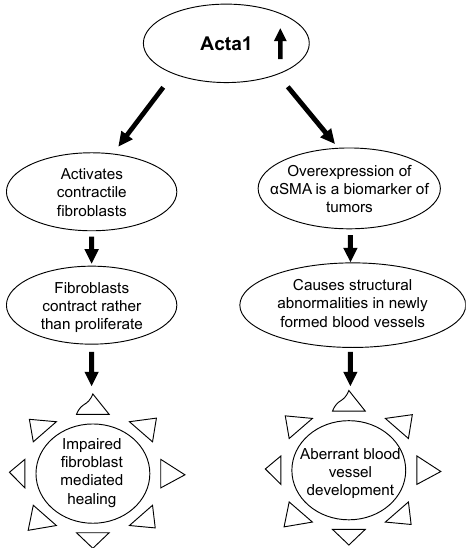
Figure 5. Overexpression of alpha smooth muscle actin during early chronicity. Acta1, the gene encoding for alpha smooth muscle actin is overexpressed in chronic wounds. The overexpression leads to the activation of contractile fibroblasts when healing at this stage requires fibroblast proliferation and not contractile fibroblasts. Hence fibroblast mediated healing is impaired. Overexpression of Acta1 also serves as a biomarker for tumors and is linked to causing abnormalities during neo-angiogenesis in tumors. This could indicate that Acta1 overexpression causes aberrant blood vessel development.